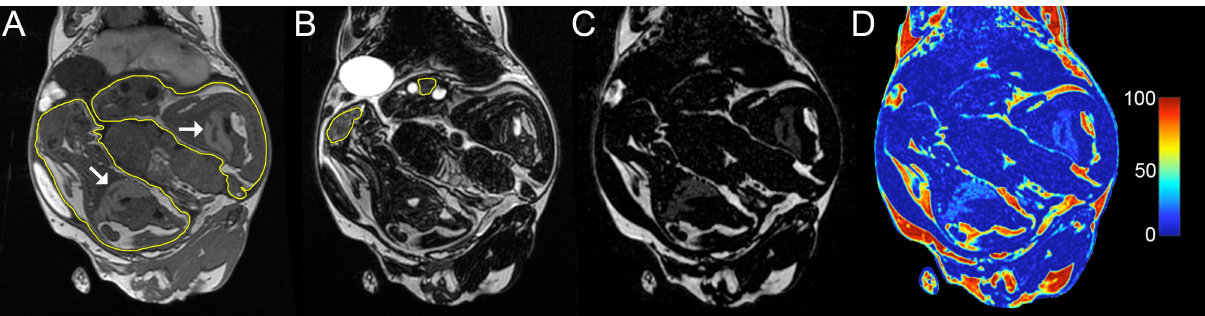
Fig 2. Coronal images of a pregnant guinea pig on a lifetime Western Diet. (A) T 1 -weighted image with fetuses contoured in yellow and fetal livers denoted by white arrows. (B) T 2 -weighted images with fetal brains contoured in yellow. (C) IDEAL fat-only image. (D) IDEAL fat fraction map. Images have been cropped to highlight the fetuses.